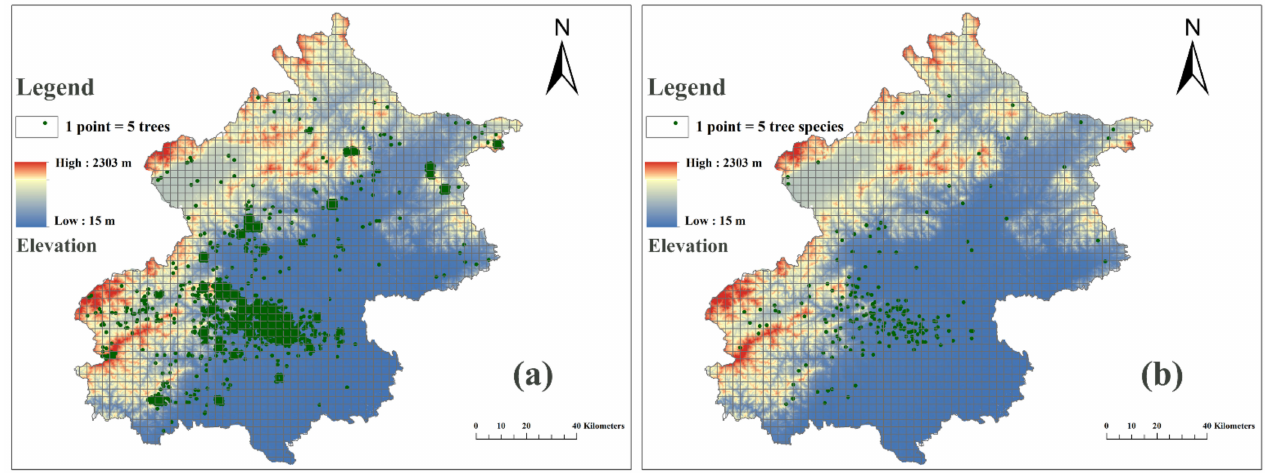
Figure 4. Spatial distribution ( a ) and tree species distribution ( b ) of large old trees in Beijing.